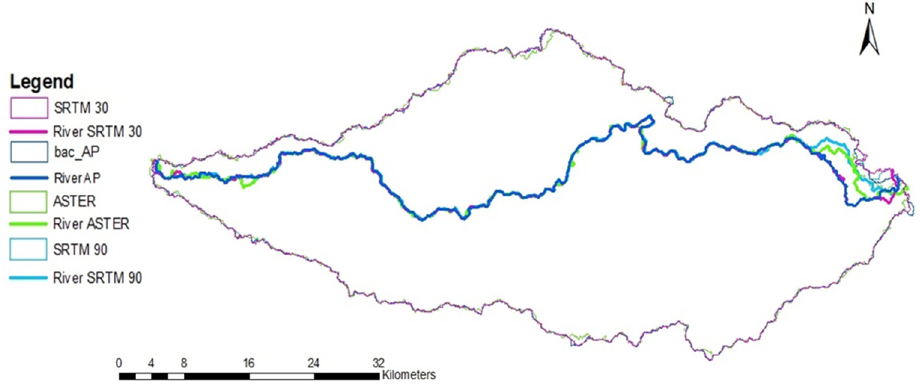
Figure 4. Basin perimeters and mainstream paths for the four DEMs.